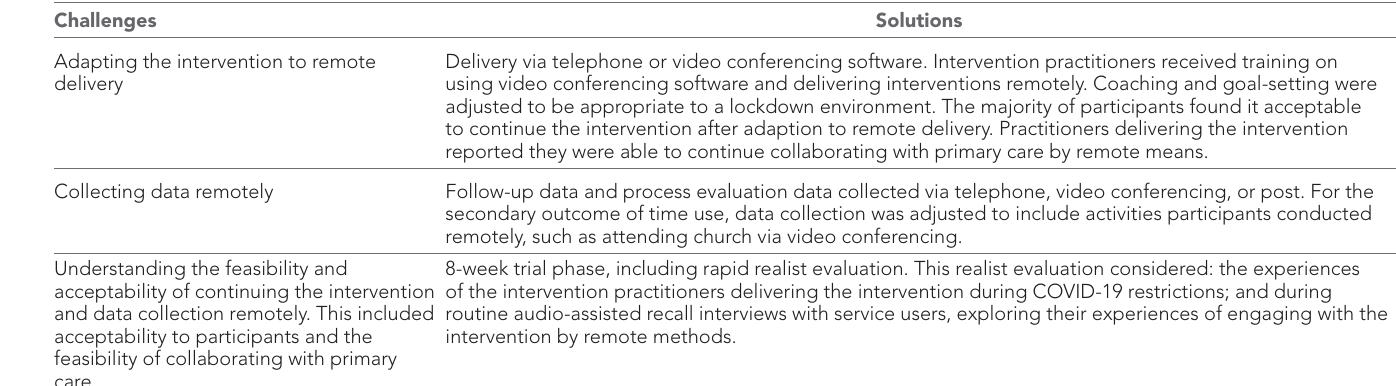
Table 2 Adjustments to the trial due to COVID-19 restrictions (8- week trial phase) Challenges Solutions Adapting the intervention to remote